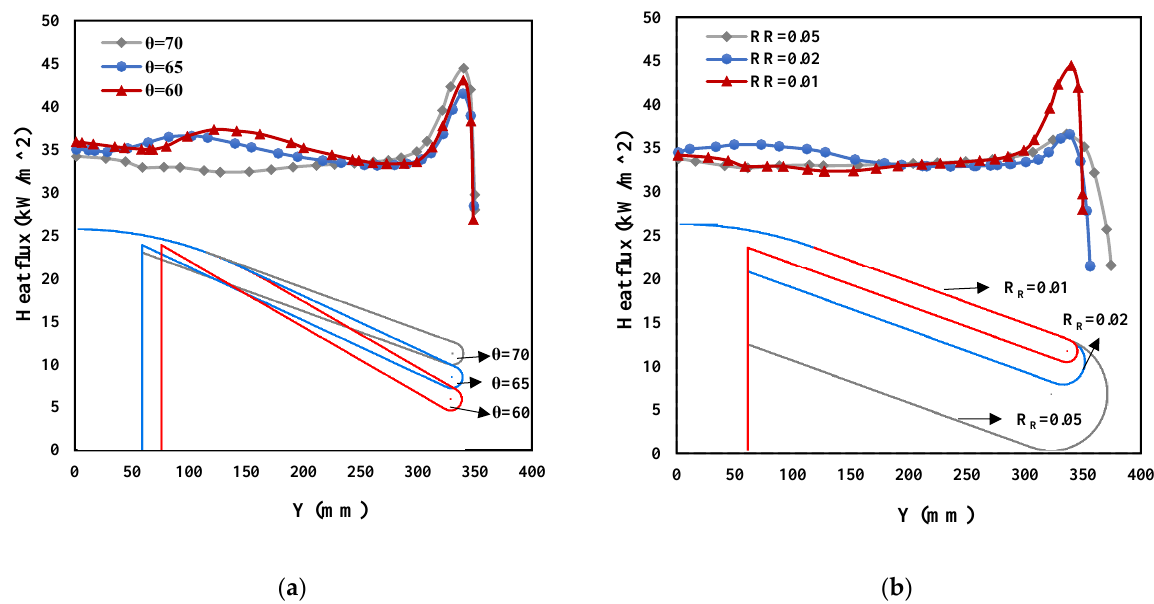
Figure 13. Heat flux distribution of case 0-0, case 3-1 to case 4-2: ( a ) θ is changed; ( b ) R R is changed.